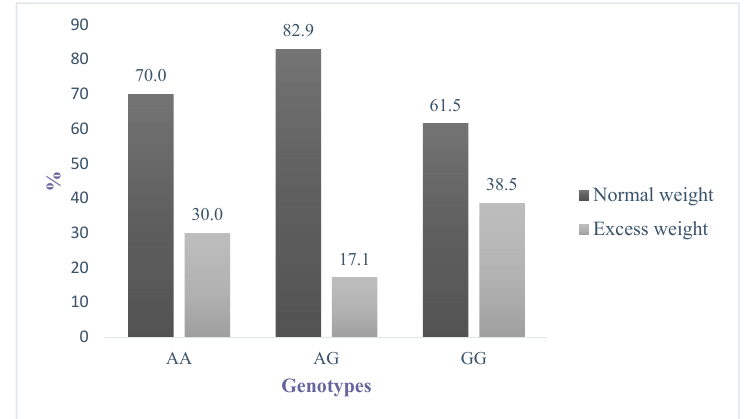
Figure 1. Differences in schoolchildren’s nutritional status according to the wild-type homozygous (AA), heterozygous (AG), and homozygous (GG) genotypes of Q223R. The GG homozygous showed the highest prevalence of overweight plus obesity. The figures presented are taken from basal results (2017). Excess weight comprises obesity and overweight rates.